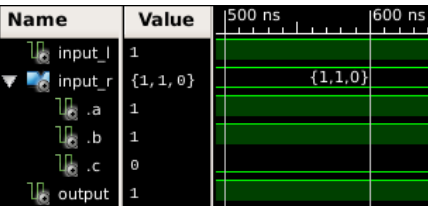
Figure 7. Internal logic structure of AND gate with right port hardened.